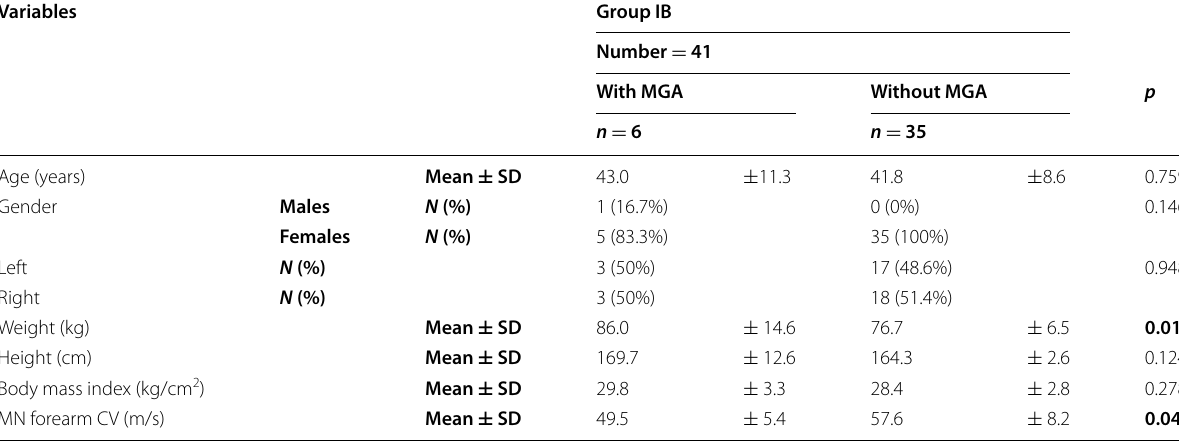
MGA Martin–Gruber anastomosis, N number, P value probability value, SD standard deviation, MN median nerve, CV conduction velocity, p > 0.05 difference